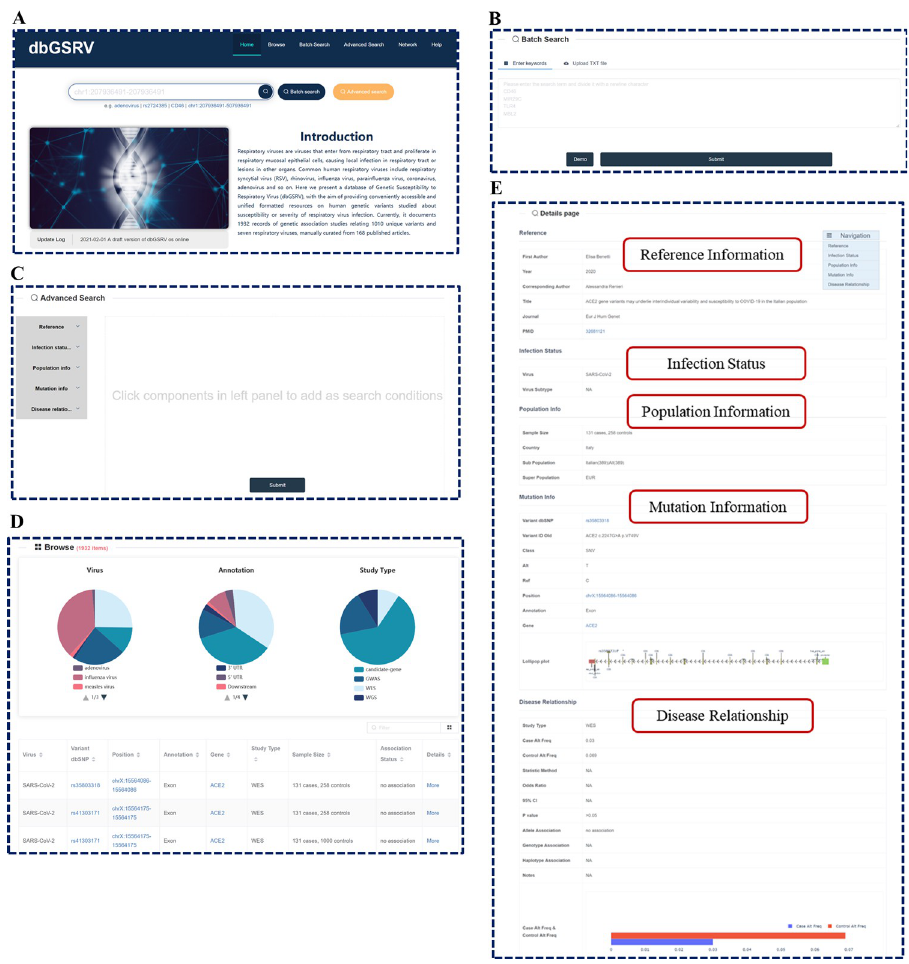
Fig 1. Screen shot of dbGSRV contents. (A) Home page. (B) Batch Search page. (C) Advanced Search page. (D) Browse page. (E) Detailed information about the record.